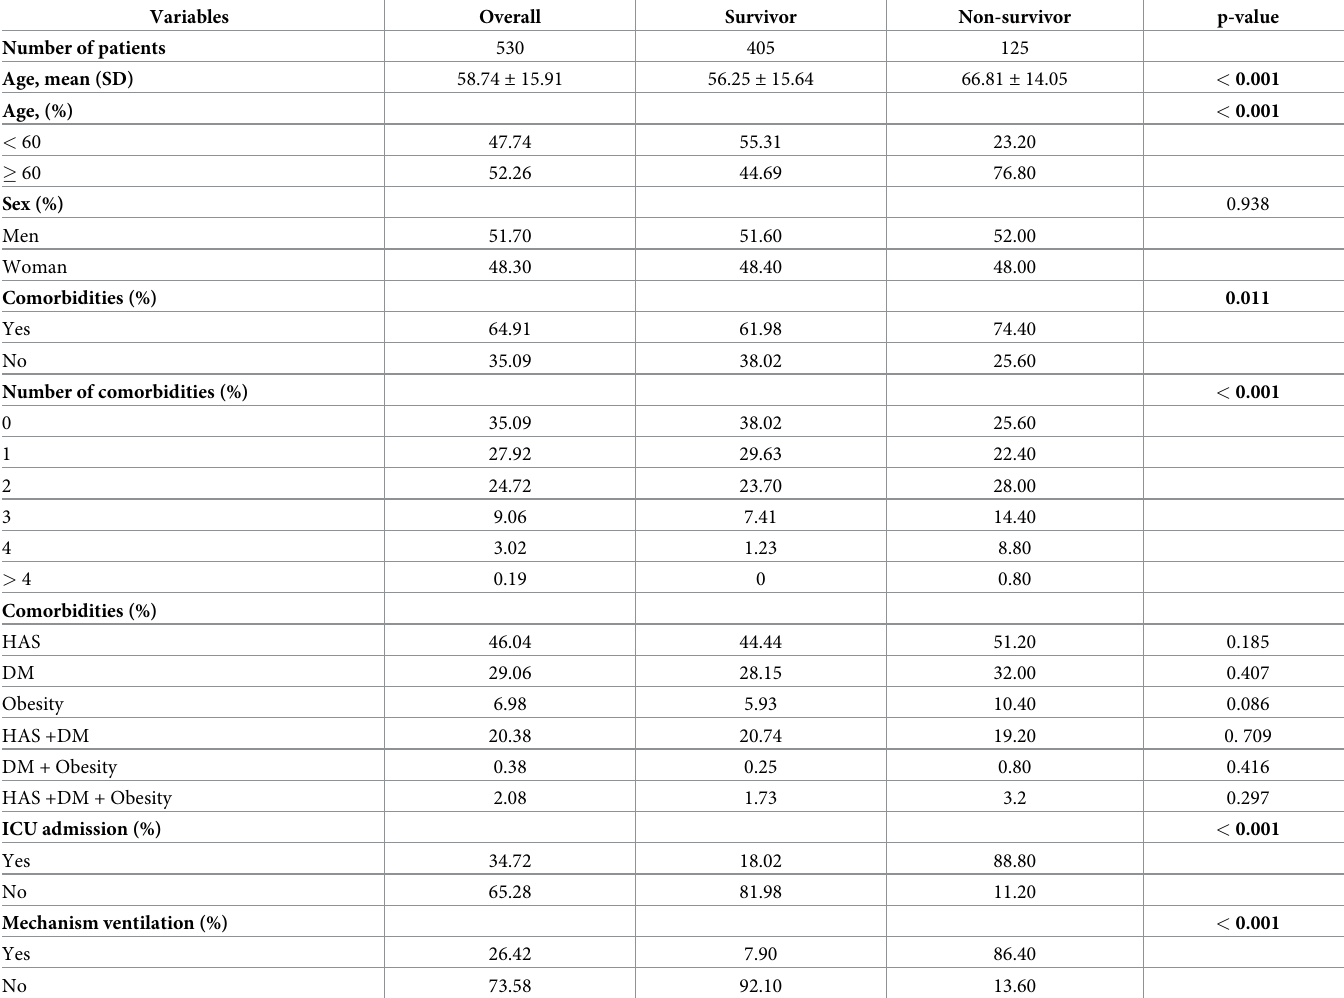
Table 1. Demographic and clinical characteristics of patients diagnosed with